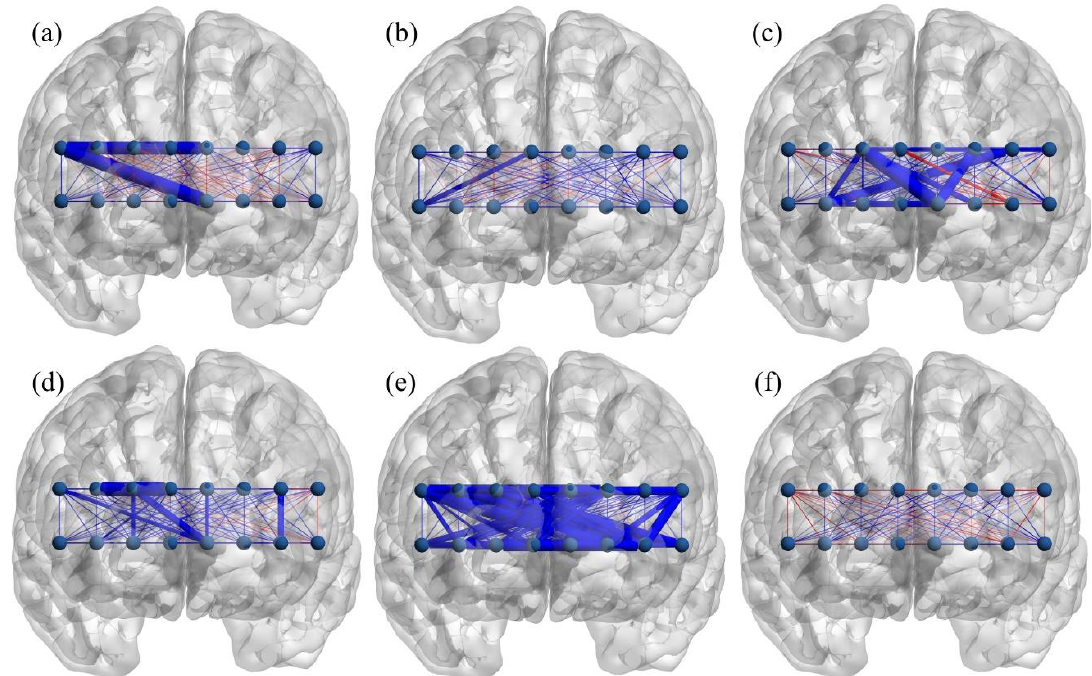
Figure 3. Brain map depicting correlation coefficients between the simple GNG connectivity and subject performance; ( a – c ) female, ( d – f ) male; ( a , d ), omission error, ( b , e ) commission error, ( c , f ) response time. Red: positive correlation, blue: negative correlation, thick edge: connection with significant correlation coefficient ( p -value < 0.05).